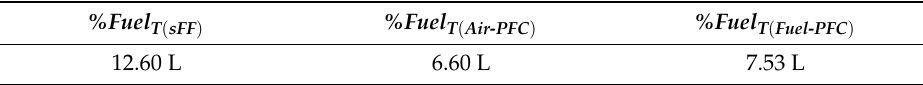
Table 2. Fuel economy of the FC system using strategy air / fuel-PFC compared to the strategies sFF, air-PFC, and